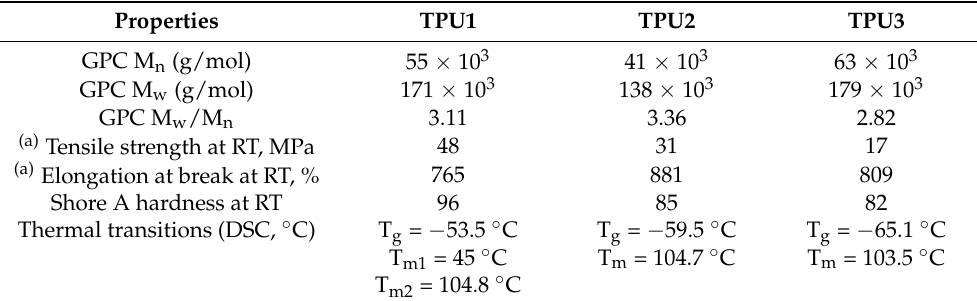
Figure 6. DSC analysis of TPUs in nitrogen atmosphere, data recorded from second heating cycle ( left ) and cooling scan ( right ). (left) and cooling scan (right). Table 4. Properties of thermoplastic